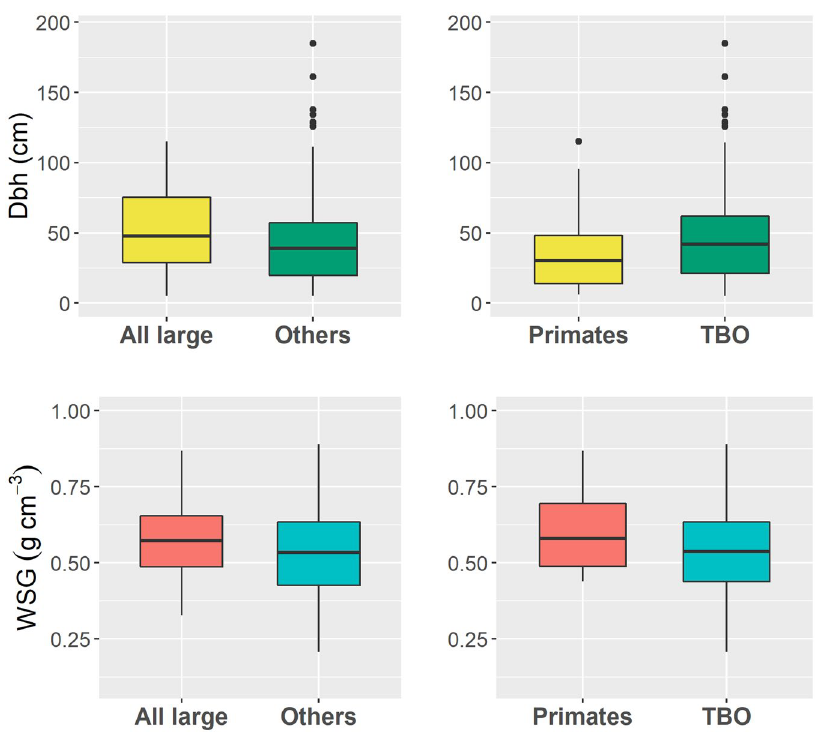
Figure 3. Maximum size and wood specific gravity: compared between trees species dispersed by all large- bodied frugivores (All large) versus the other agents (Others; left panels), and compared between primate- dispersed species (Primates) versus species dispersed by terrestrial mammals, birds and other large dispersers (TBO; right